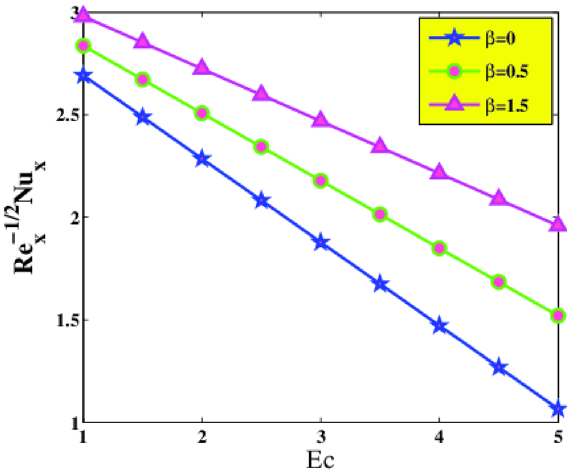
Figure 12. Nusselt number Nu x via Ec and β .